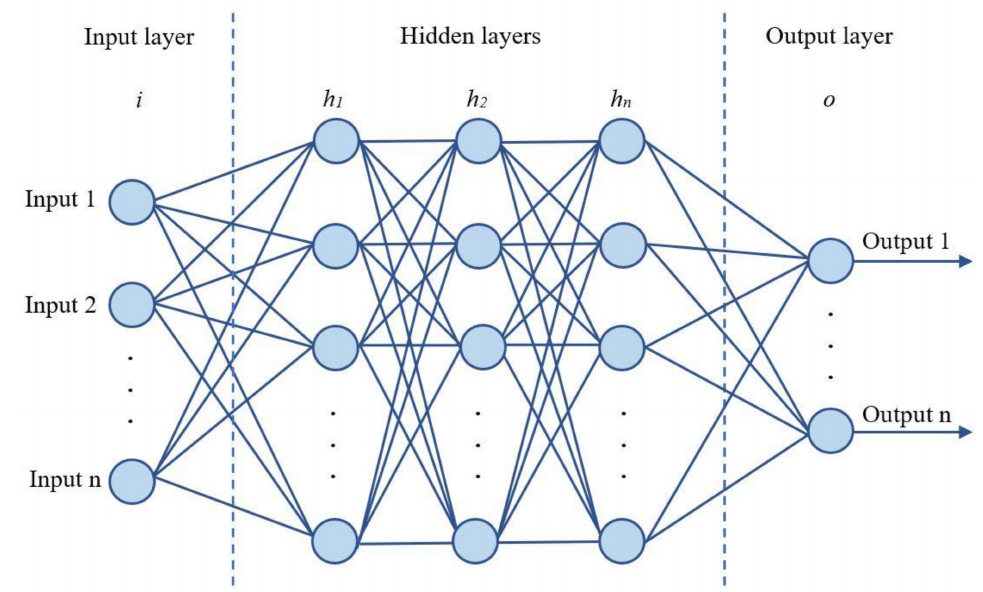
Figure 1. Deep neural network architecture.